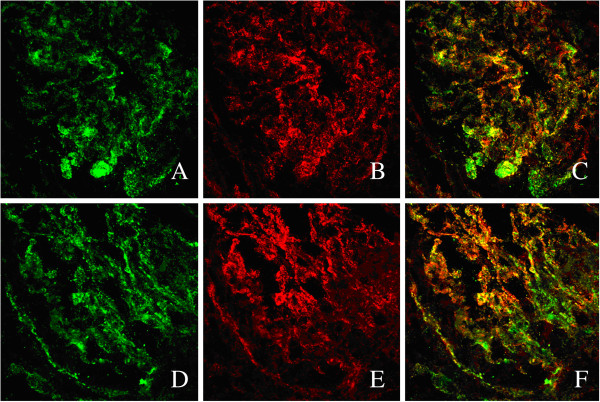
Co-localization of C1q and IgG staining in glomeruli in lupus nephritis. A&D. Granular positive staining of C1q by immunofluorescence along the glomerular capillary wall and mesangial area in a patient with lupus nephritis. B&E. Granular positive staining of IgG by immunofluorescence along the glomerular capillary wall and mesangial area in the same section in Figure 1A or D. C&F. C1q and IgG co-localized completely along the glomerular capillary wall and mesangial area, merged in yellow. (Original magnification × 800).